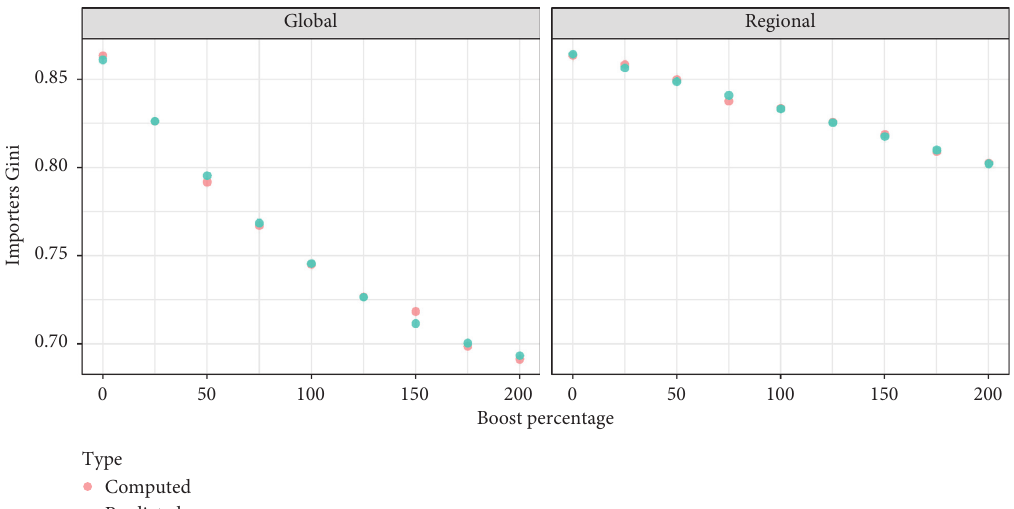
Figure 6: Computed and predicted average improved importer Gini indexes for year 2005. A second-order polynomial was fitted to the global data while regional data follows a linear